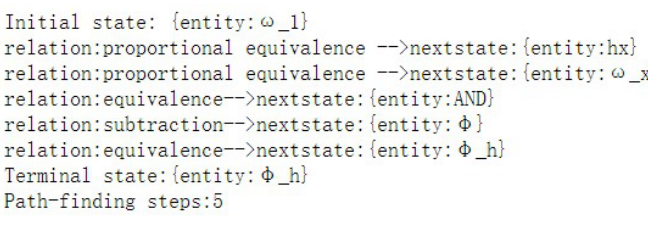
Figure 6. Visual output result of program.